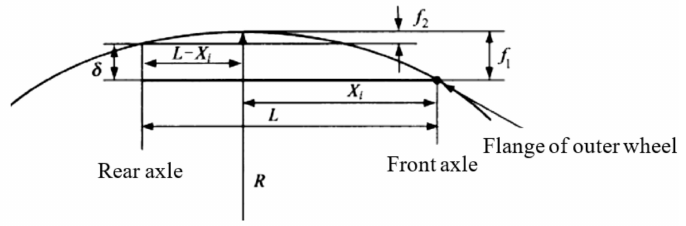
Figure 3. Gap calculation based on dynamically free inscribing.